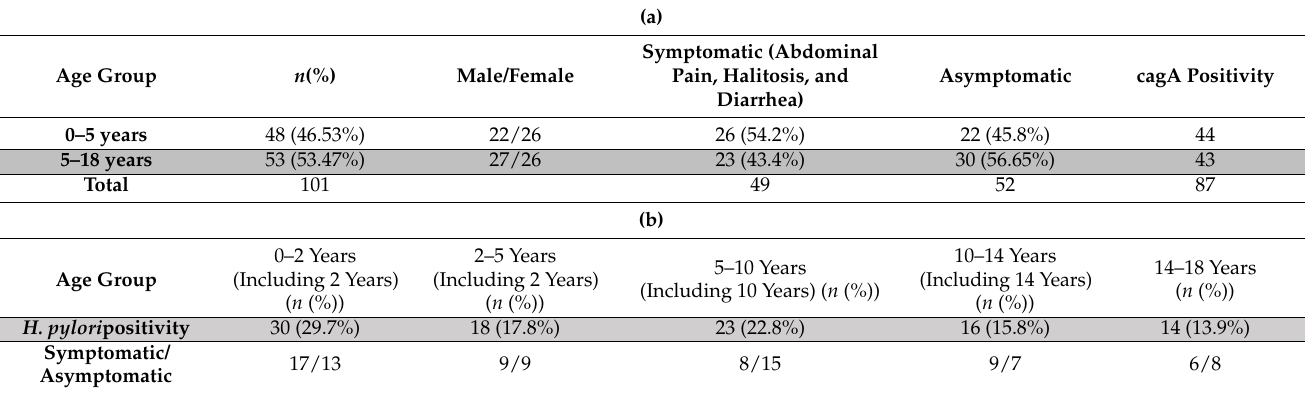
Table 2. ( a ). The characteristics of the different age groups. ( b ) H. pylori positivity of different age